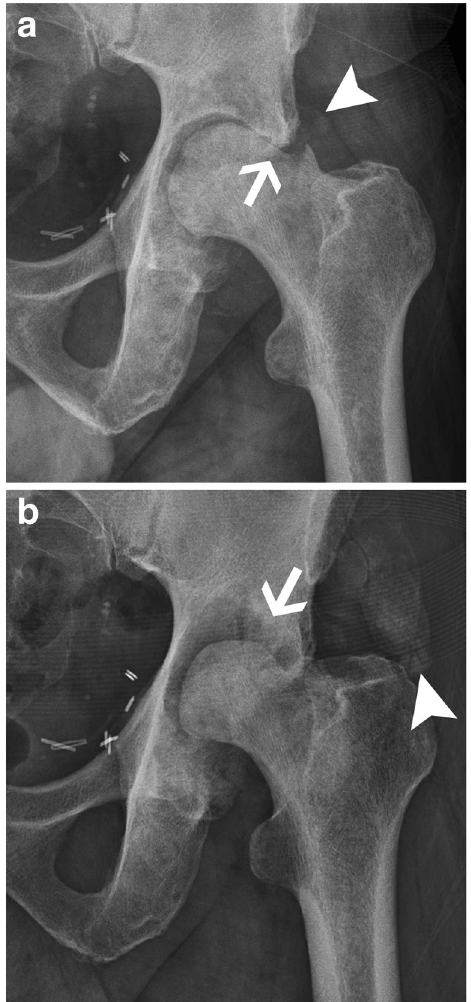
Fig. 13 Rapid degenerative arthropathy. ( a ) Anteroposterior radiographs initially and ( b ) 3 months later show progressive bone lysis (arrows) and periarticular calcifications (arrowheads)